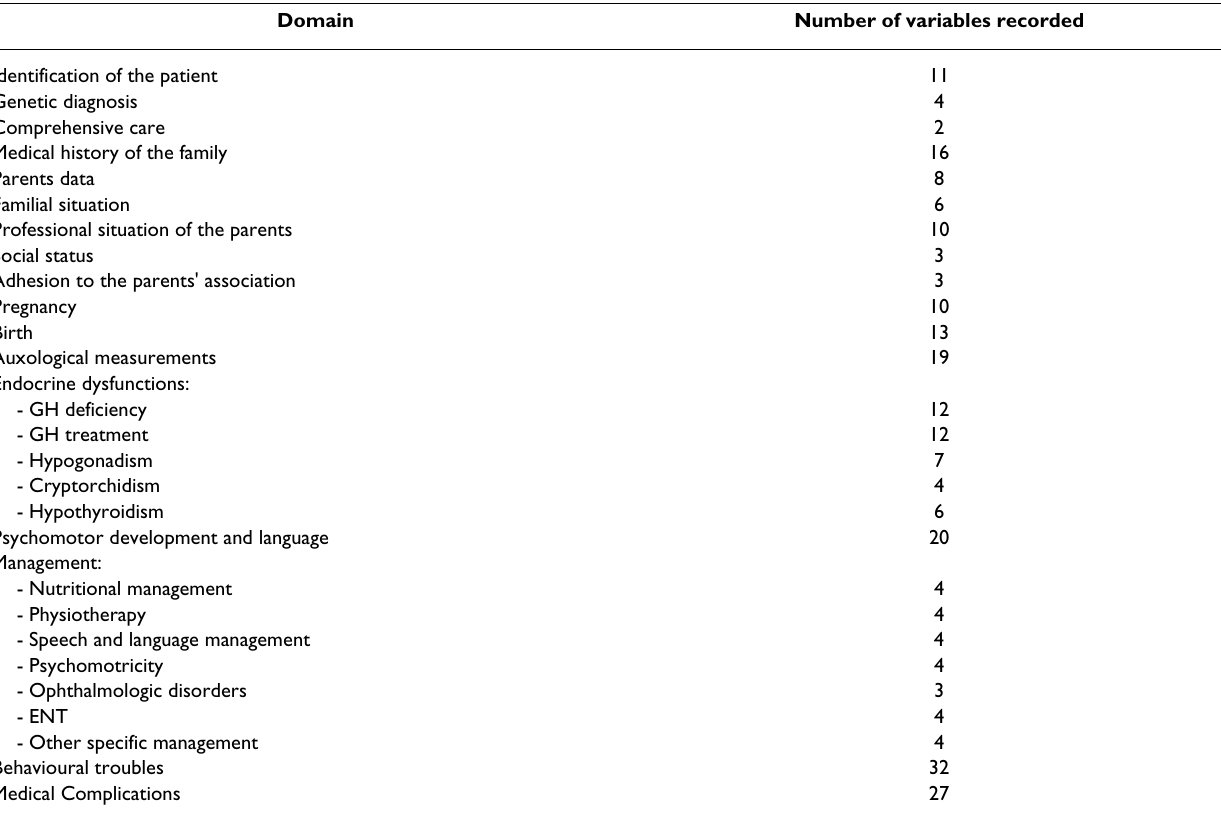
Table 1: List of variables of the medical and socio-demographic (MSD) form